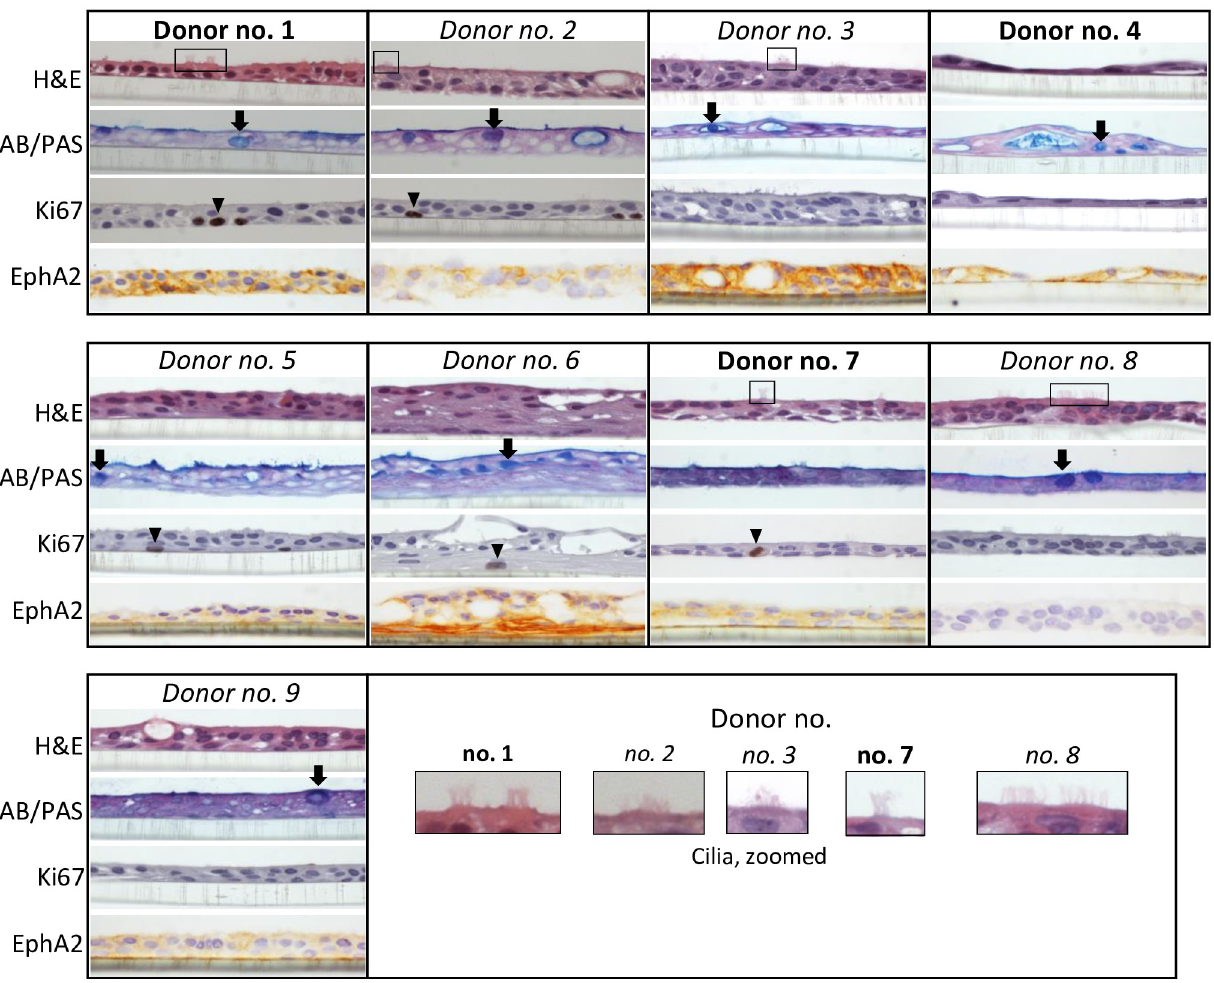
Fig 1. Histological analysis of pseudo-ALI cultures derived from the nasopharynx for markers of cellular differentiation and the EBV epithelial cell receptor. Shown are pseudo-ALI cultures susceptible (bold) and non-susceptible (italics) to de novo EBV infection. Examples of ciliated cells are marked by a black box in the Hematoxylin & Eosin (H&E) stain. Mucin-producing cells are marked by a black arrow in the Alcian blue/periodic acid Schiff (AB/ PAS) stain. Basal cells that are proliferating are marked by a black arrowhead in the Ki67 stain. Expression of the EBV epithelial cell receptor, Ephrin type- A receptor 2 (EphA2), is indicated by brown 3, 3’–diaminobenzidine (DAB) staining counterstained with nuclear